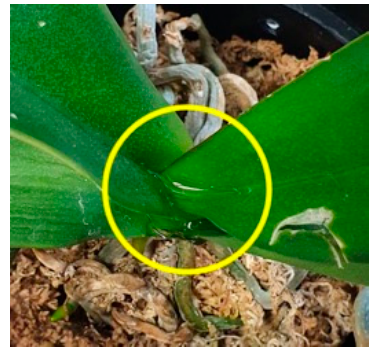
Figure 31. Demonstration of watering on the junction between the stem and leaves.